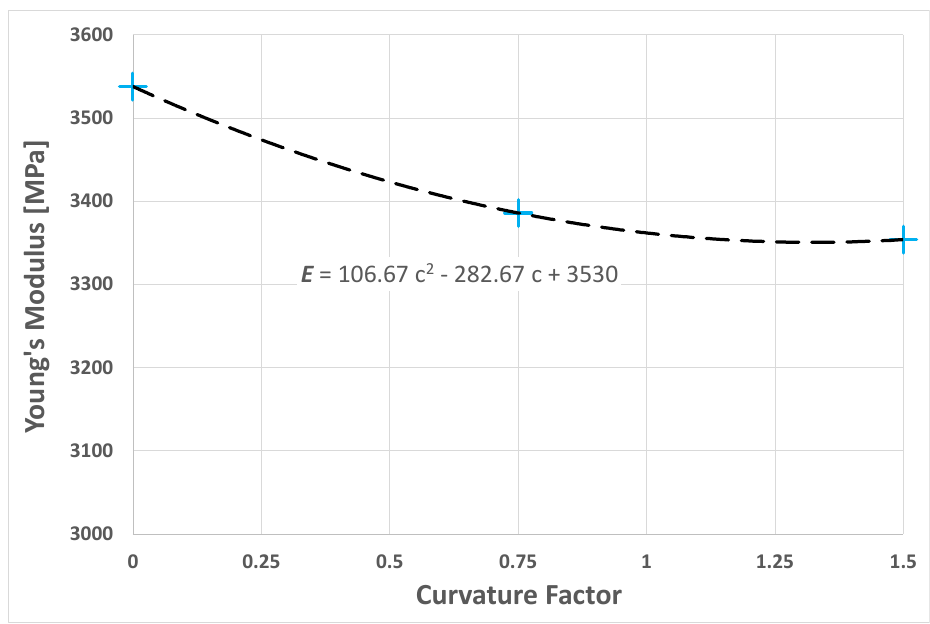
Figure 13. Graph of the Young’s modulus of the composite as the mean curvature factor of the fibers varied in an RVE with V f = 0.1.